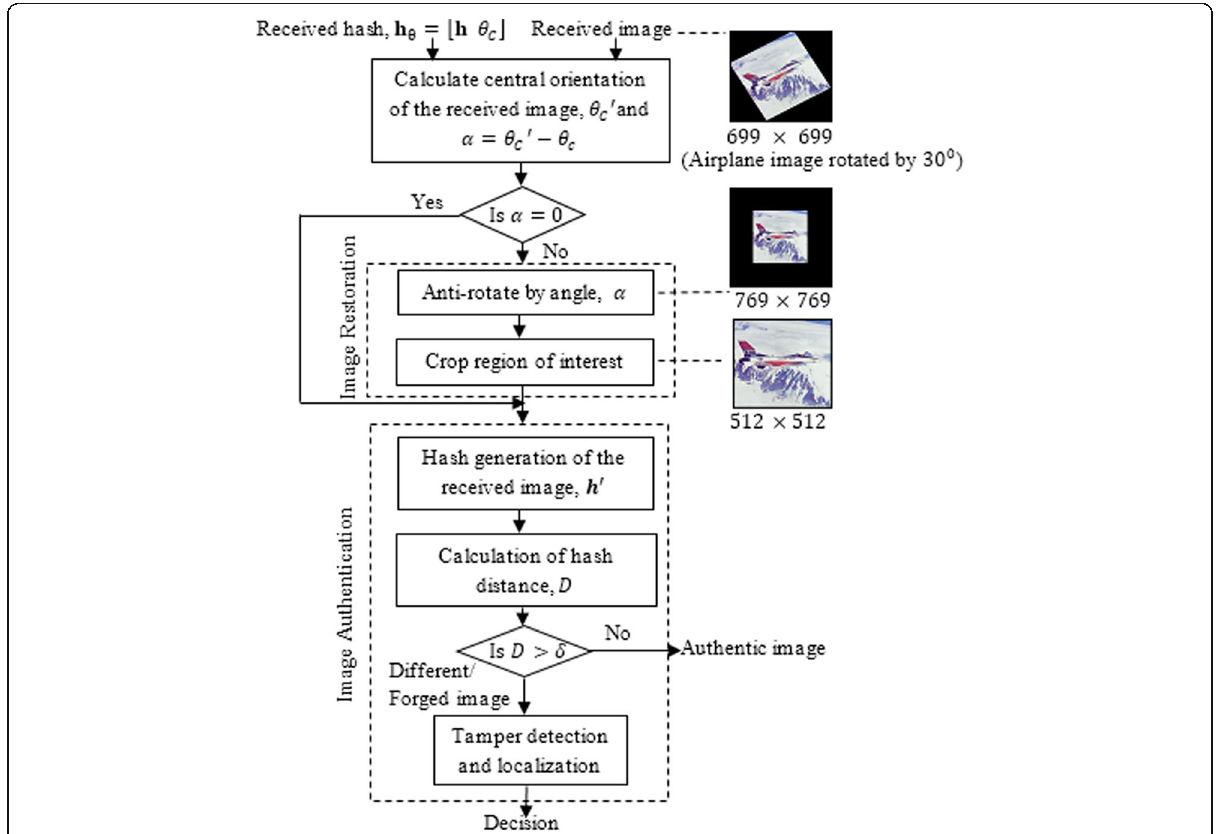
Fig. 4 Depict the image restoration and authentication